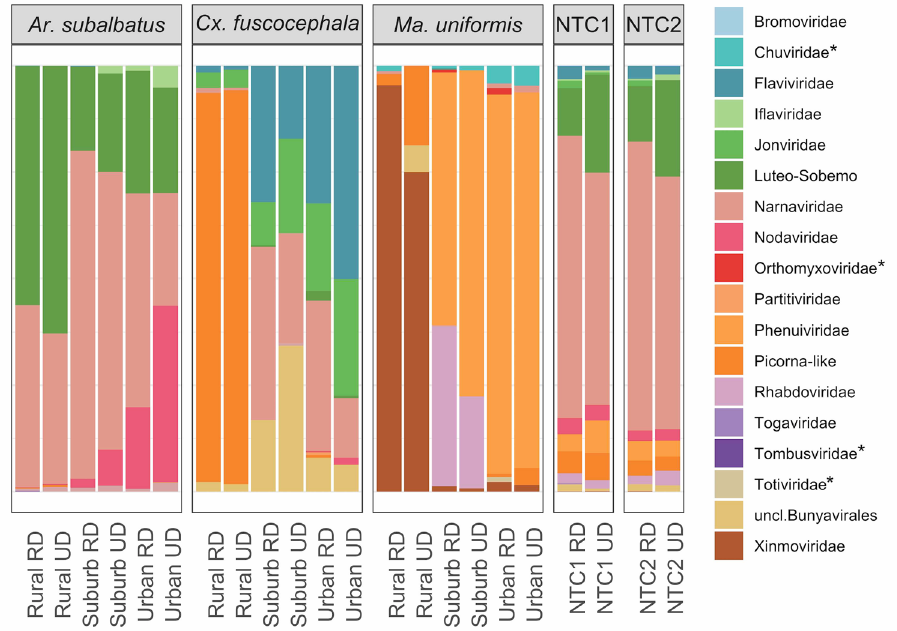
Figure 2. The proportion of virus families found in all mosquito samples and NTCs. RD = rRNA depleted, UD = rRNA not depleted. Asterisks (*) indicate virus groups that are likely contamination. NTC1 and NTC2 refer to no-template controls for separate sequencing runs (Supplementary Table